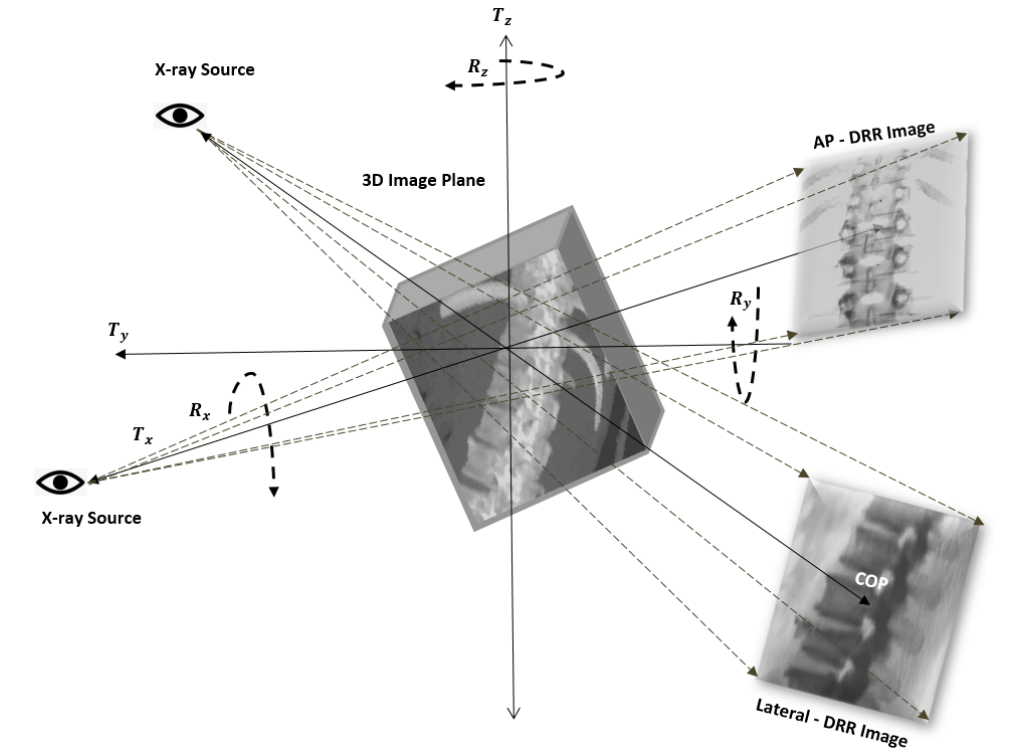
Figure 1. Depiction of projection image generation in the Anterior–Posterior (AP) and lateral direc- tions during the intensity-based 3D-2D